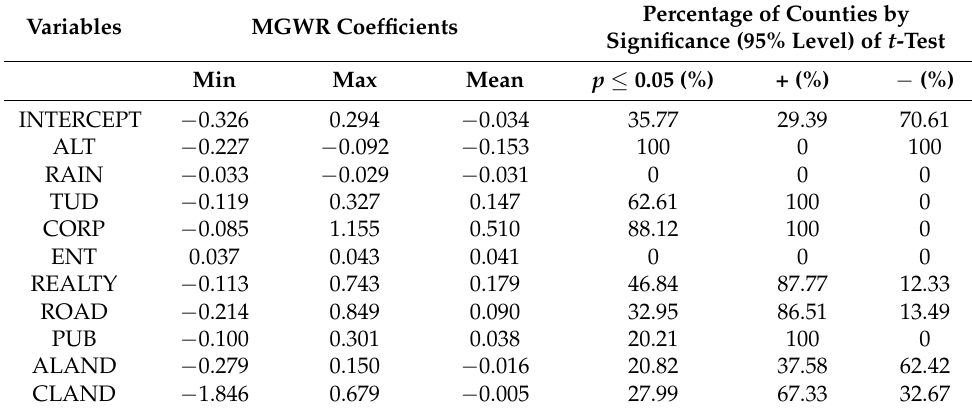
Table 3. Parameter estimates for the regression of GDP using